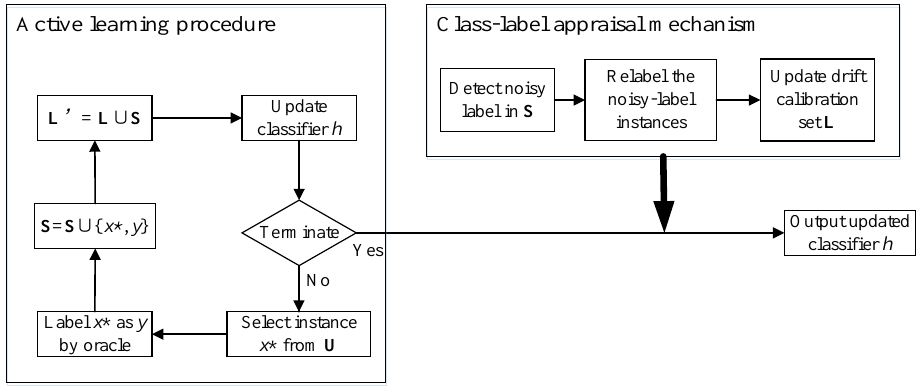
Figure 2. Improved AL-based drift calibration framework.